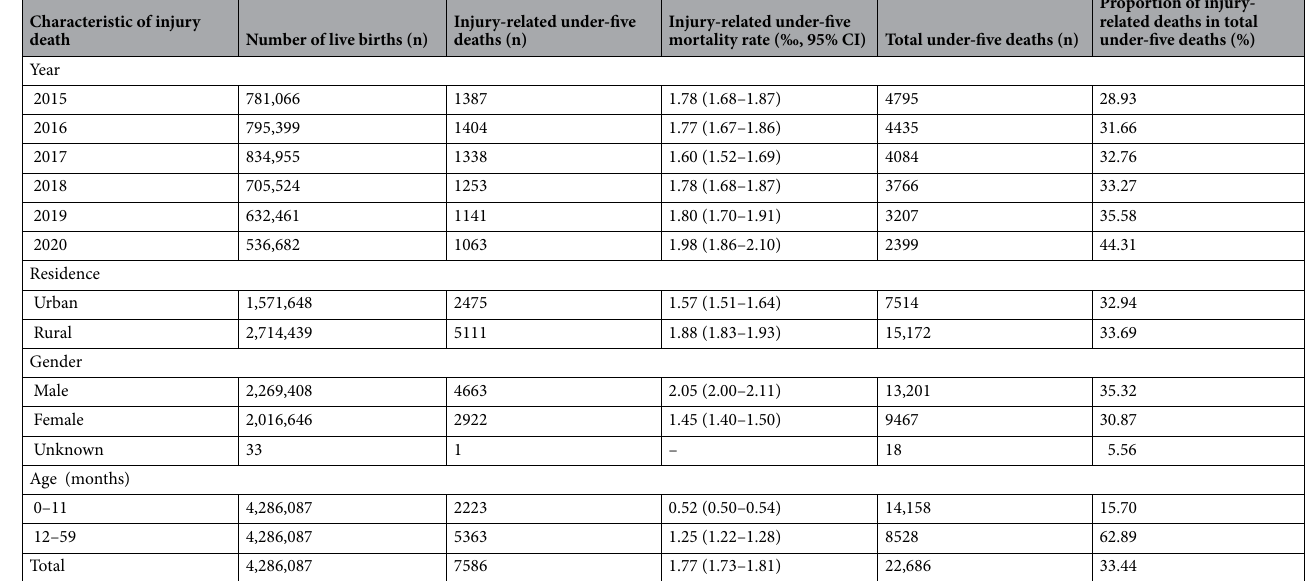
Table 1. Injury-related under-five mortality rate in Hunan Province, China, 2015–2020. CI confidence interval.